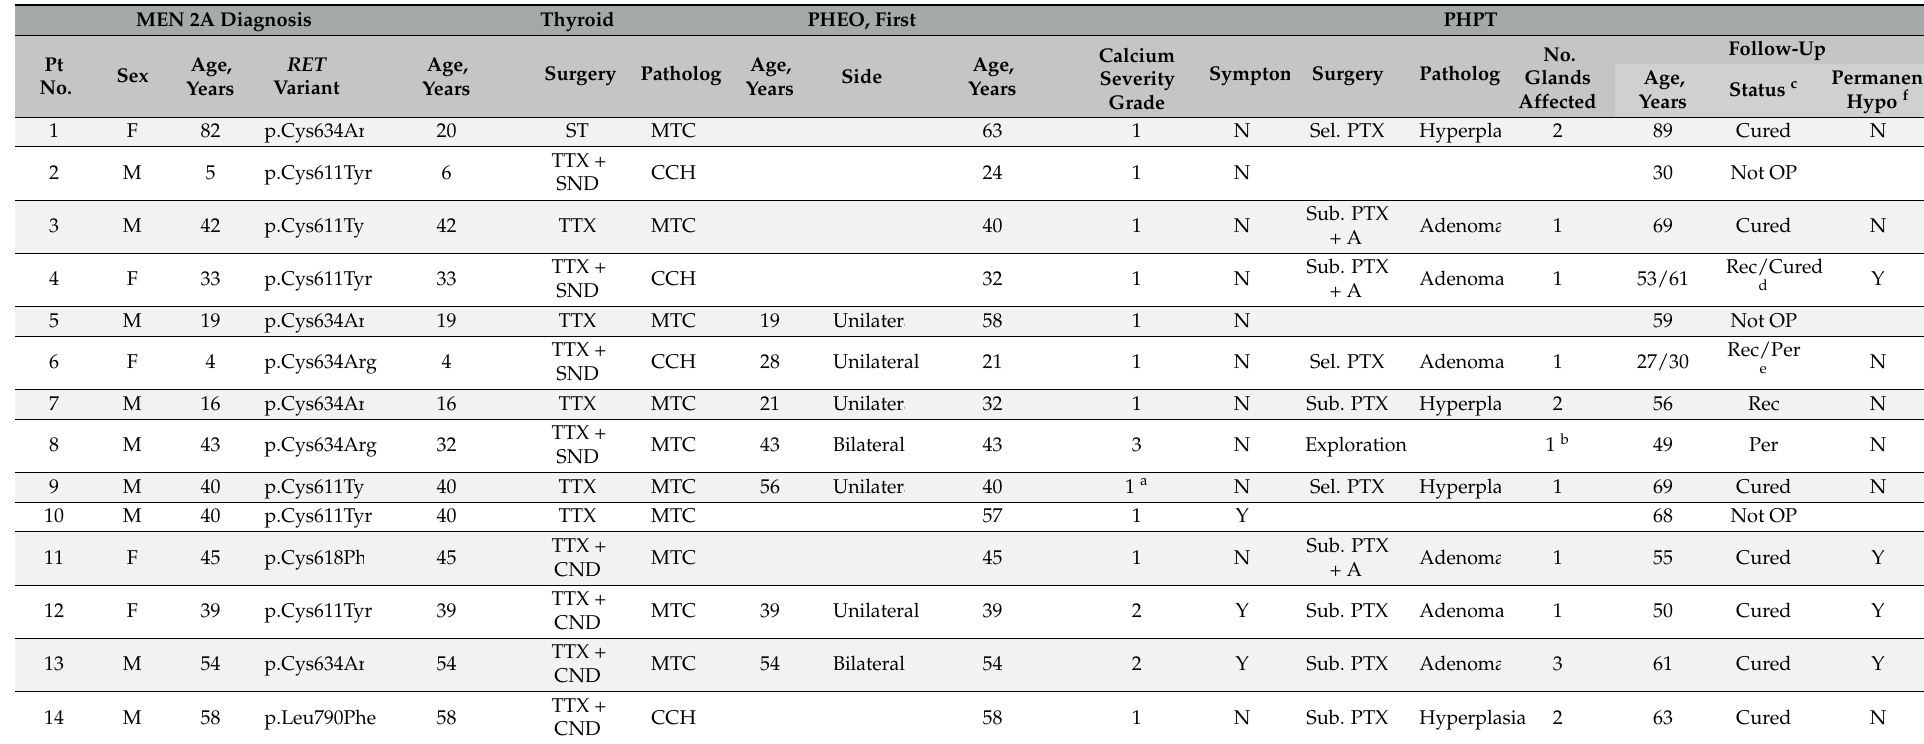
Table 1. Characteristics of patients with PHPT from the Danish MEN 2A cohort